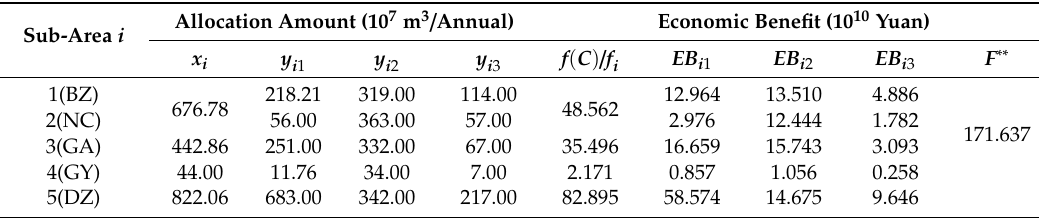
Table 5. Water allocation result under cooperation (information symmetry, BZ and NC).